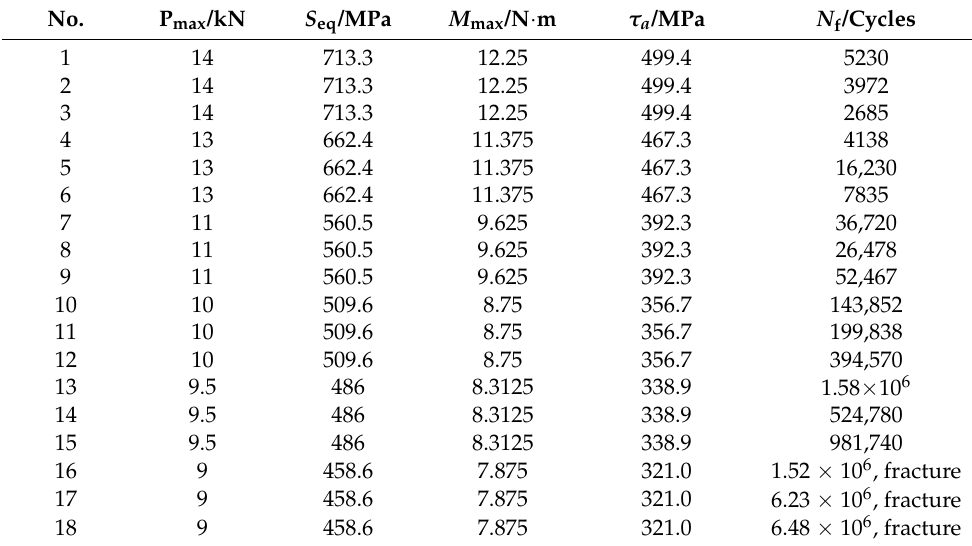
Table 2. Fatigue test results under 90 ◦ non-proportional tension–torsion loading.